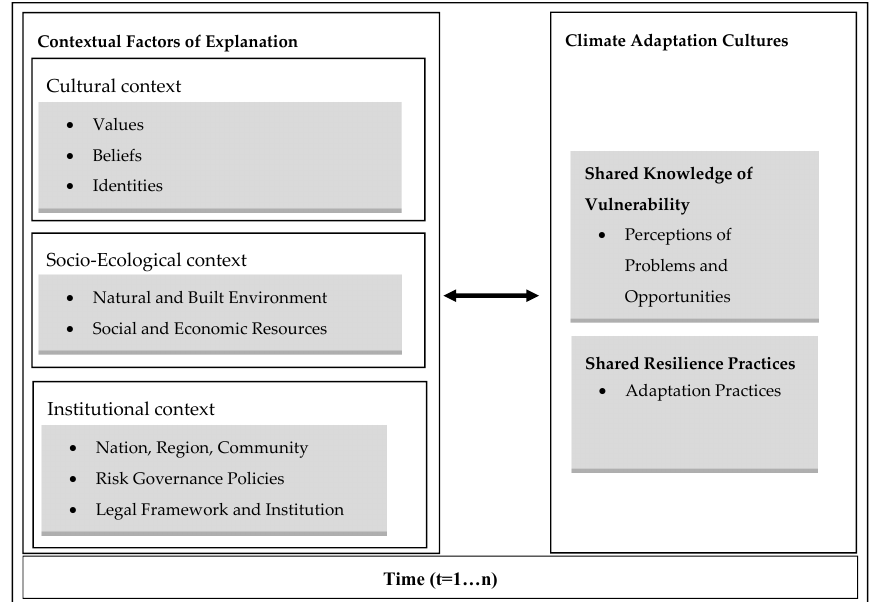
Figure 3: Proposed explanatory framework of climate adaptation cultures. Figure 3. Proposed explanatory framework of climate adaptation cultures. Figure 3. Proposed explanatory framework of climate adaptation